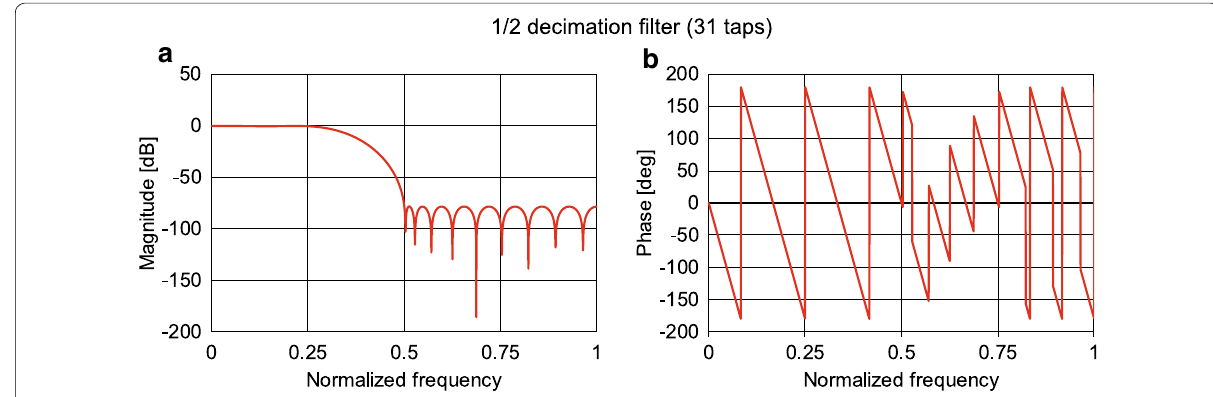
Fig. 11 Frequency responses of the anti-aliasing filter for the 1/2 decimation filter (31 taps). a Magnitude, b phase